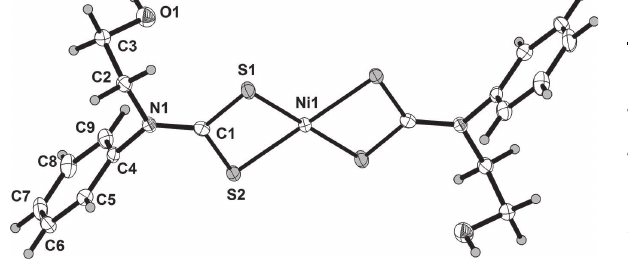
Table 1: Data collection and handling.